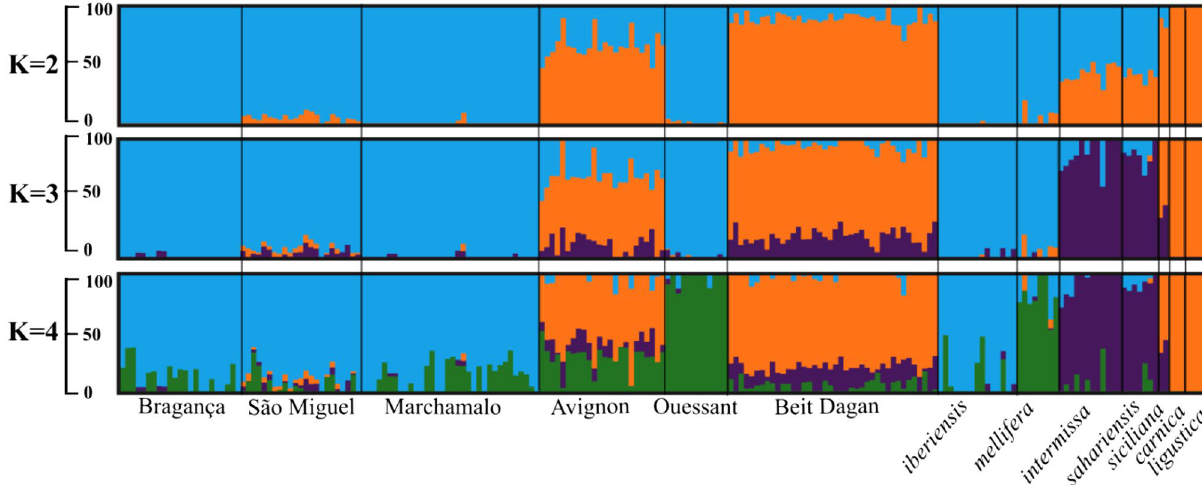
Figure 5. Admixture plots showing the membership partitioning (Q-value) from two (K = 2) to four clusters (K = 4). Each individual is represented by a vertical bar. The black vertical lines separate individuals from different populations (Bragança and São Miguel-Portugal; Marchamalo-Spain; Avignon and Ouessant- France; Beit Dagan- The MAF distribution for each SNP and population is shown in Supplementary Fig. S1. Locus HB938 is the least polymorphic (MAF = 0.05) whereas HB310 is the most polymorphic, with both alleles displaying equal frequencies (MAF = 0.5). For 75.8% of the SNPs, the greatest contrast in allelic distribution is exhibited between Beit Dagan plus Avignon and the remaining populations (Ouessant, Bragança, São Miguel, Marchamalo). This contrasting pattern is further reflected by membership proportions (Q-values) inferred by ADMIXTURE for one to seven K genetic groups. According to the cross-validation error, the most likely K is three (Supplementary Fig. S2), although it is only at K = 4 that the two M-lineage subspecies ( A. m. mellifera and A. m. iberiensis ) split (Fig. 5). At K = 4, populations from Avignon (average Q-value = 0.575, Supplementary Table S6) and Beit Dagan (average Q-value = 0.774, Supplementary Table S6) share an important genetic component with the eastern Euro- pean A. m. carnica and A. m. ligustica reference subspecies (orange cluster). This suggests that both populations are mostly of C-lineage commercial ancestry, although they also have a background assigned to the clusters of the reference subspecies A. m. mellifera (green cluster) and the north African A. m. intermissa and A. m. sahariensis subspecies (purple cluster). On the other hand, the remaining populations show negligible levels of C-lineage ancestry and they are assigned to clusters that match the historical distributional ranges of the subspecies, i.e. samples from Portugal and Spain are assigned mostly to the A. m. iberiensis cluster (blue) and samples from Ouessant (France) are assigned to the A. m. mellifera cluster (green).